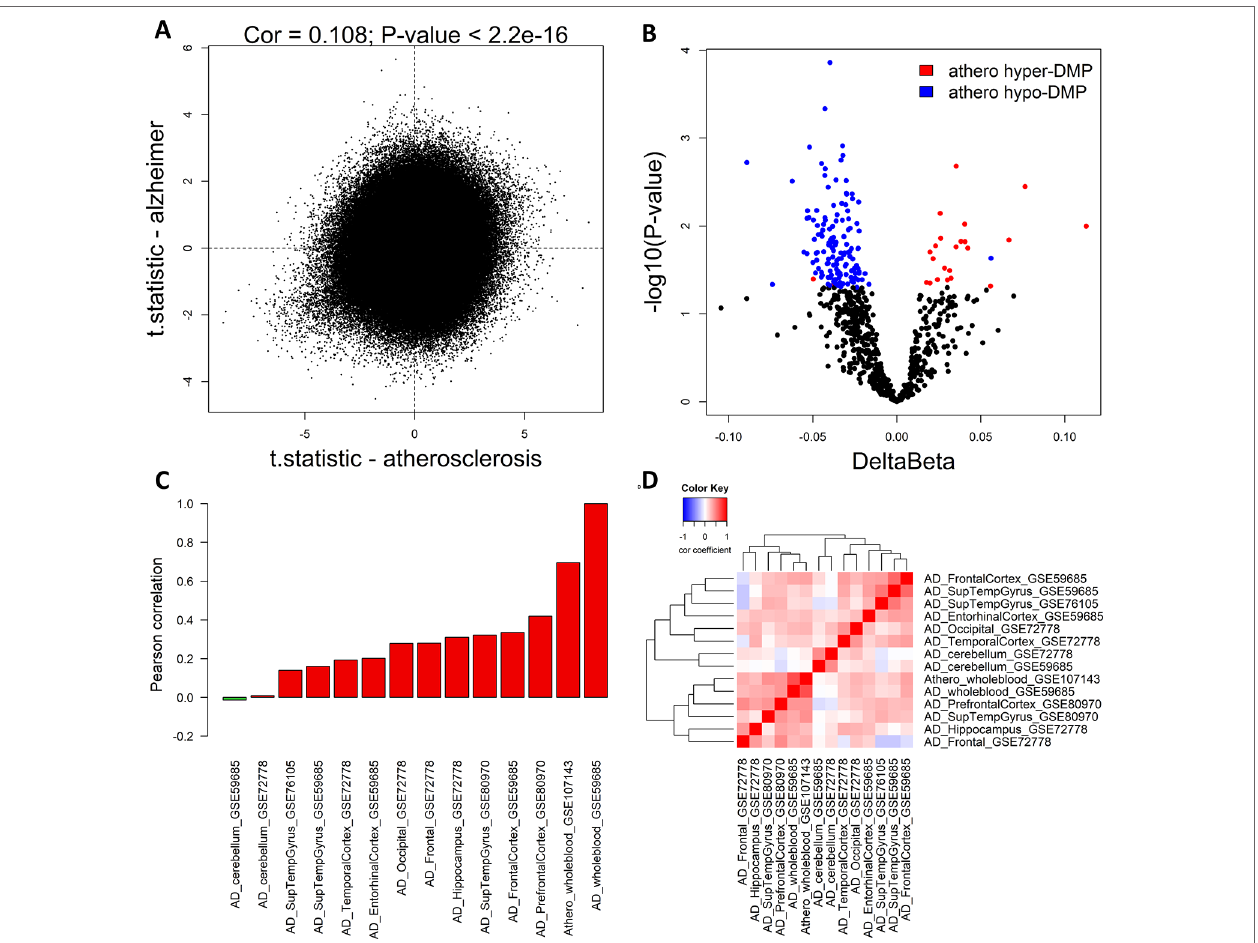
FIgURe 1 | Common DNA methylation signature in atherosclerosis and Alzheimer's disease (AD) whole blood and brain samples. (A) The genome-wide significance levels (t-statistic) of each CpG-probe in the atherosclerosis (GSE107143) and AD (GSE59685) whole blood dataset was plotted in the X-axis and Y-axis, respectively. The Pearson correlation was used to calculate the correlation between the two datasets. (B) Volcano plot showing the methylation differences and statistical significance values after comparing the methylation values of the 712 top significant atherosclerosis differentially methylated positions (DMPs) (athero- DMPs) between AD patients and healthy individuals. Probes which were significantly different between AD and controls (p-value < 0.05) were colored blue when hypomethylated and red when hypermethylated in atherosclerosis. (C) Correlation coefficients between the t-statistics of the 712 athero-DMPs in the atherosclerosis whole blood dataset and the t-statistics of the athero-DMPs in multiple AD brain and whole blood datasets. Positive correlations are represented as a red bar, and negative correlations as a green bar. (D) Correlation heatmap representing the correlation coefficients between the t-statistics of the 712 athero-DMPs across different AD datasets. Red means a positive correlation and blue a negative correlation.